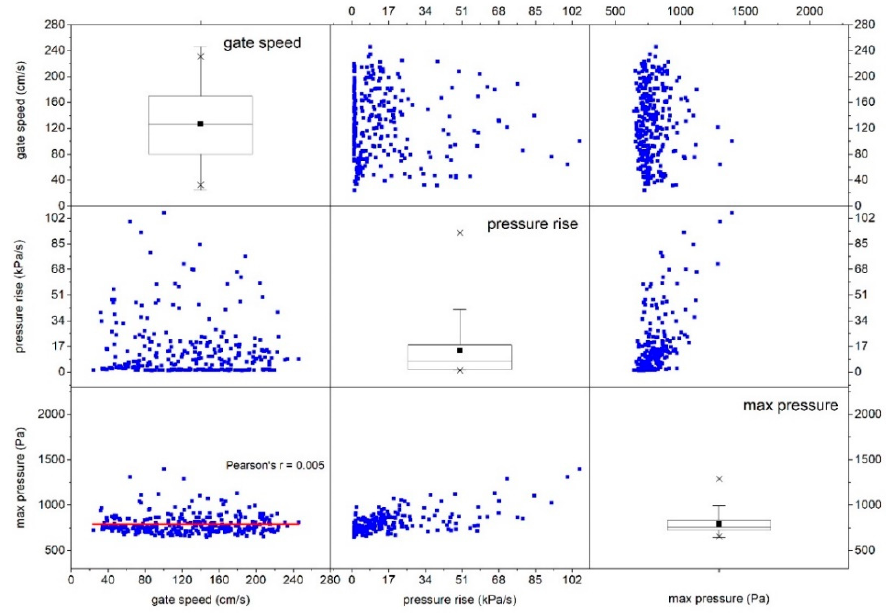
Figure A4. The matrix presenting the relationship between maximum pressure, pressure rise rate, and gate speed at